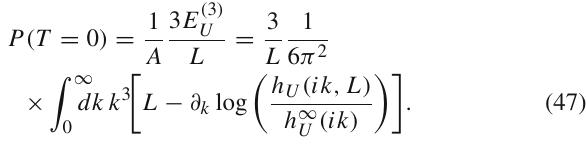
the free parameter α that determines the elements of M